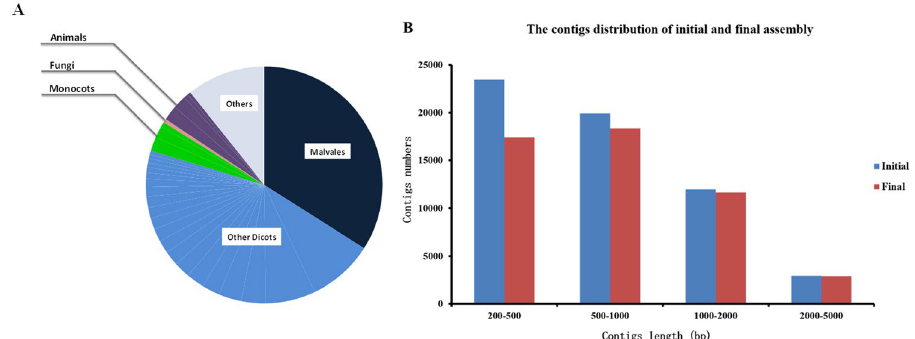
Figure 1. Summary of evaluation on assembly and annotation. ( A ) Top 25 BLASTX hits. Totally, there are six groups were blast hited and individual pieces in each group indicate different families therein. ( B ) Comparison between final (filtered) and initial (un-filtered) transcriptome of P. kingtungense . X axis represents transcript length and y represents transcripts frequency, indicating that filtering step proved important for obtaining qualified transcripts as it not only removed of the redundancy but also filtered shorter